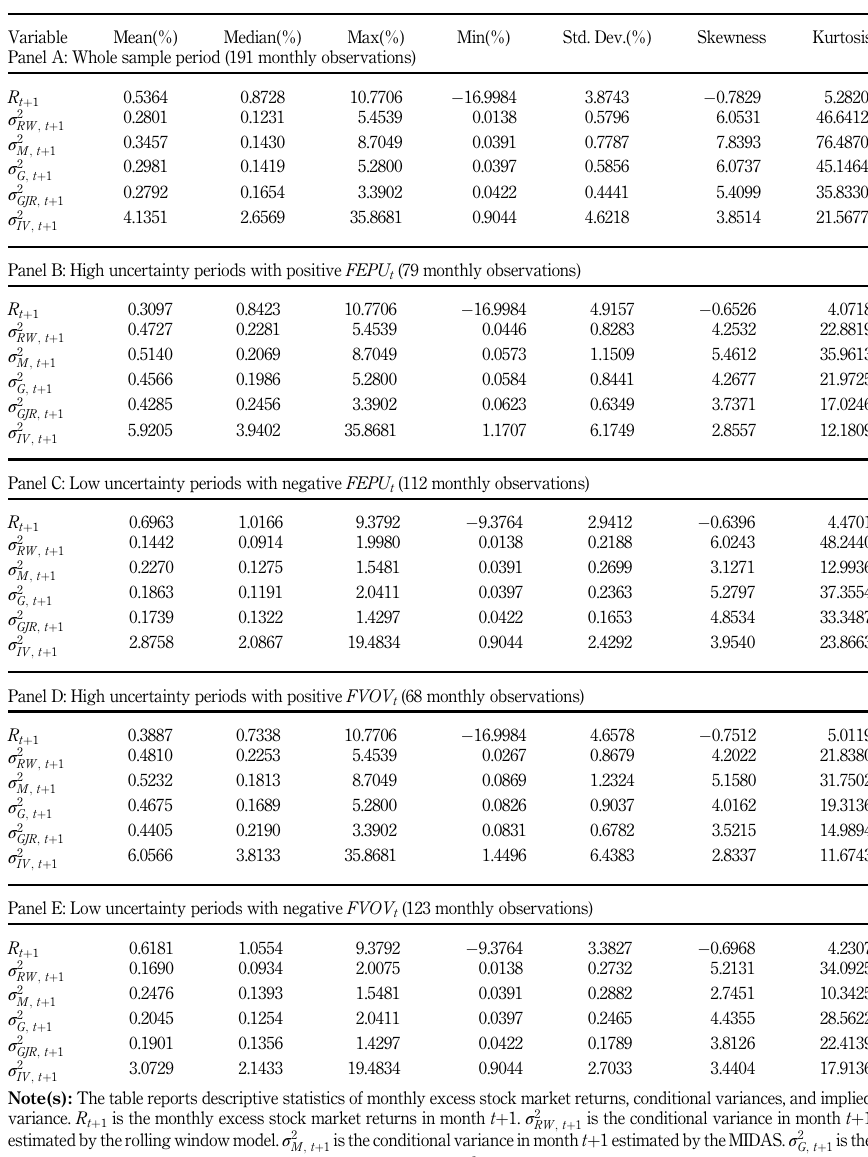
Table 2. Descriptivestatisticsof monthly excess stock market returns, conditional variances and implied